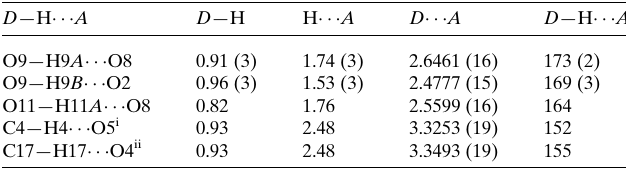
Table 1 Hydrogen-bond geometry (A˚ , (cid:5) ) for 1 .